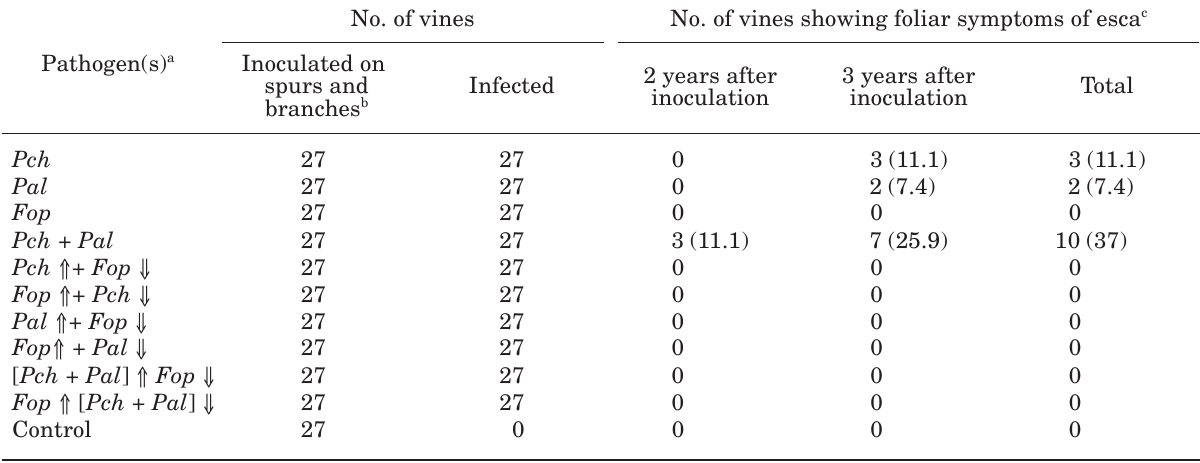
Table 2. Inoculation of grapevines cv. Matilde with Phaeomoniella chlamydospora ( Pch ), Phaeoacremonium aleophilum ( Pal ) and Fomitiporia punctata ( Fop ) after two and three year. No. of